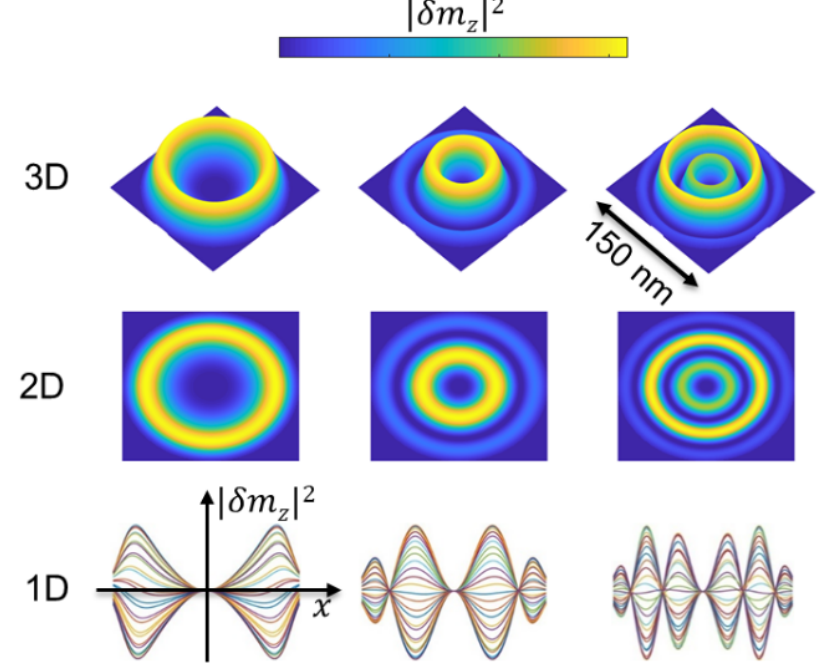
Figure 8. Mode profiles corresponding to eigenfrequencies identified in Figure 6